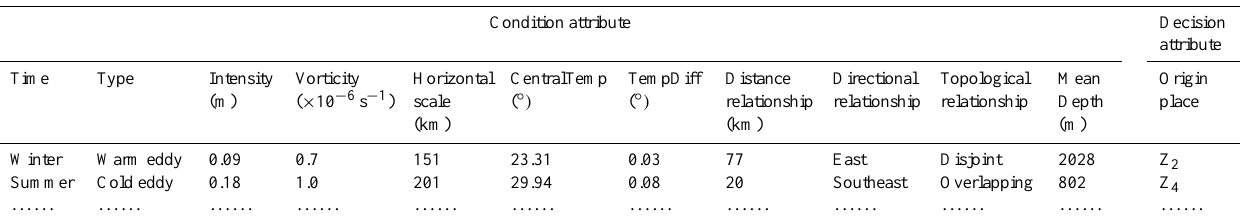
Table 2. Decision table constructed from spatial-temporal relationships of mesoscale-eddy states in 4 zones of the SCS. Condition attribute